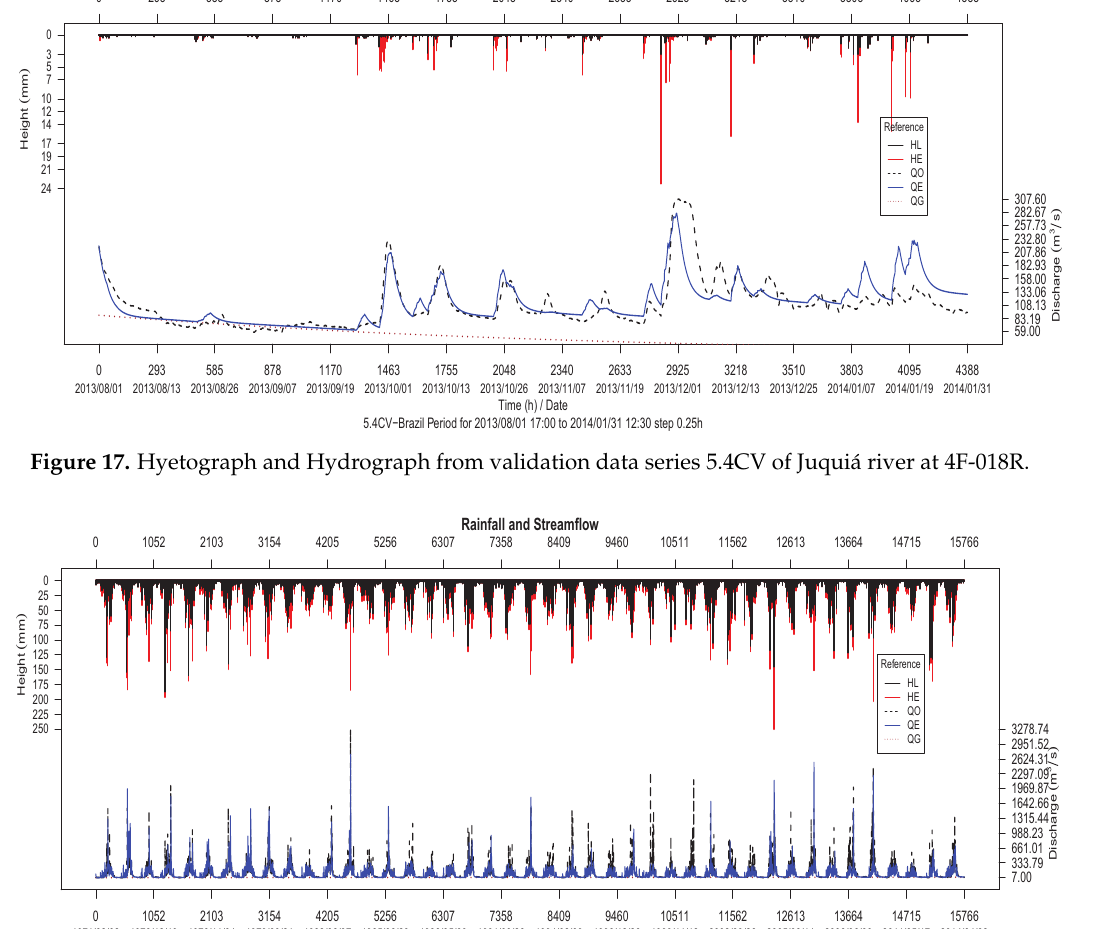
24.0hNumber of days / 6.2CV−Argentina−Bermejo−Balapuca Period for 1971/02/02 09:00 to 2014/04/03 09:00 step Figure 18. Hyetograph and Hydrograph from validation data series 6.2CV of Balapuca, Bermejo river, Bolivia-Argentina.